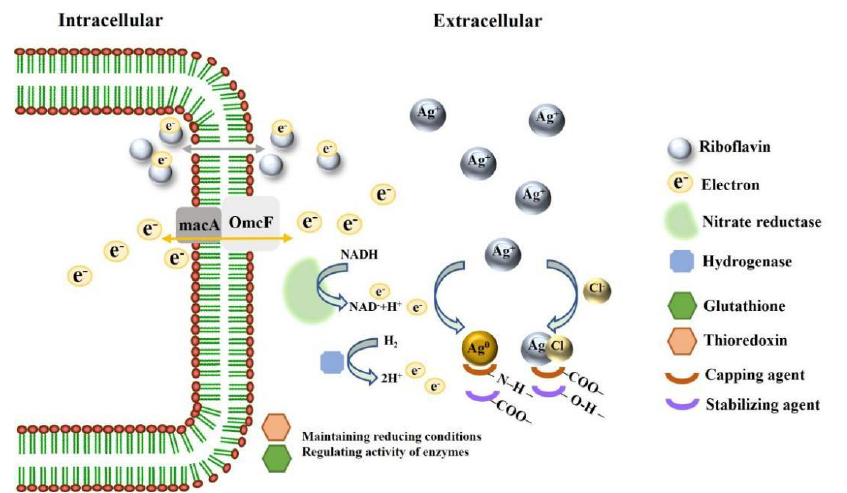
Figure 10. Schematic diagram on mechanisms of synthesizing Ag@AgCl NPs.